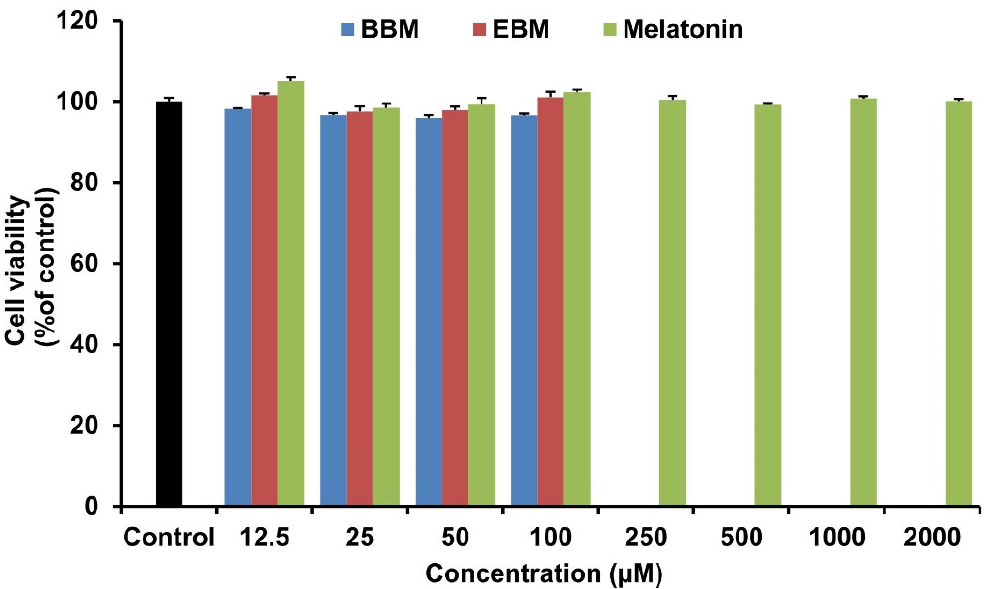
Figure 2. Viability of RAW 264.7 cells after treatment with melatonin, BBM, and EBM in various concentrations. The percentage cell viabilities were calculated relative to viability of the vehicle-treatment group. Values are expressed as means ± S.E.M (n = 8).